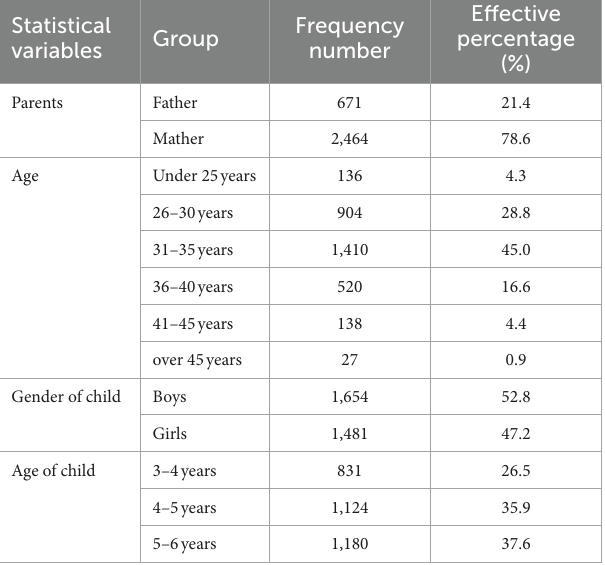
TABLE 1 Demographic characteristics of participants ( N =